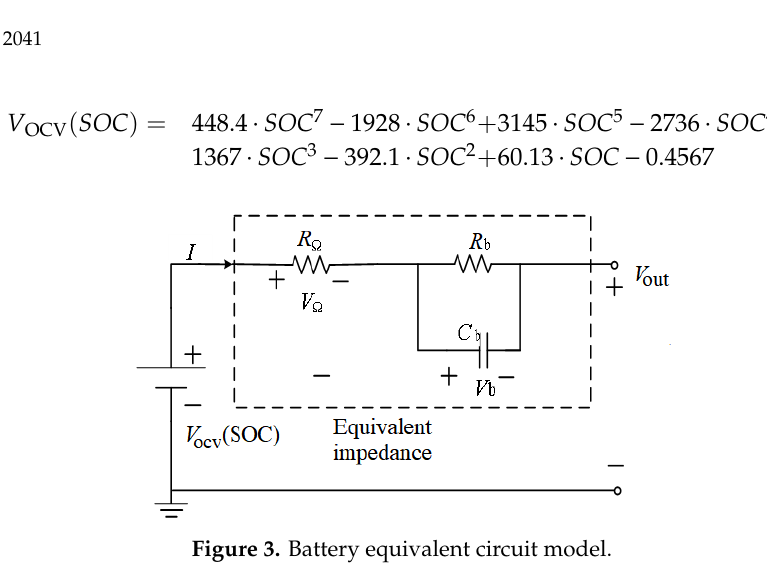
Figure 2. Test equipment uC-ZS08.